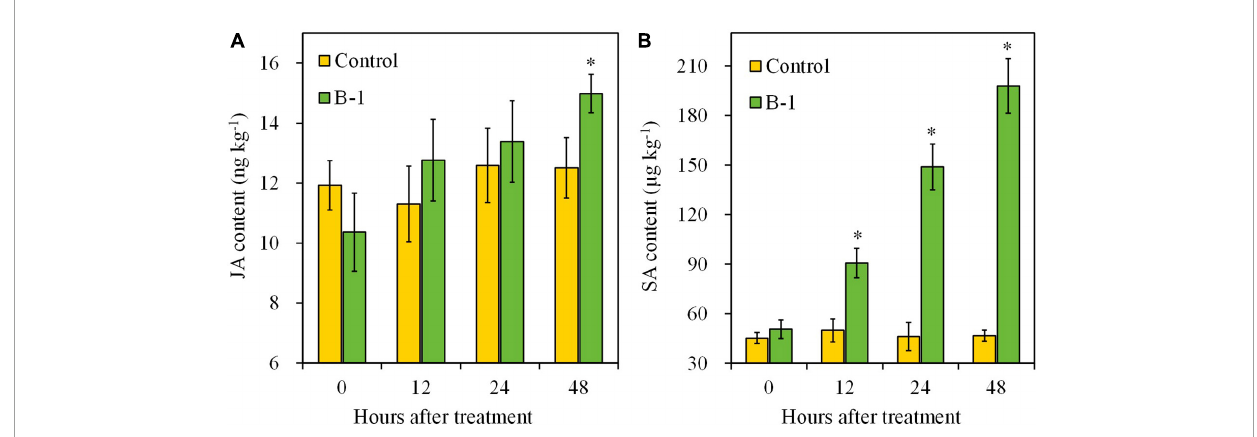
FIGURE8 The content of JA (A) and SA (B) in apple fruit treated with P. syringae B-1 at 1 × 10 8 CFU mL– 1 stored at 25 ◦ C. Each data represents the mean ± SD of three replicates. Asterisks ( ∗ ) denote a significant difference ( p < 0.05) between the strain B-1 treatment and the control apple fruit at the same time